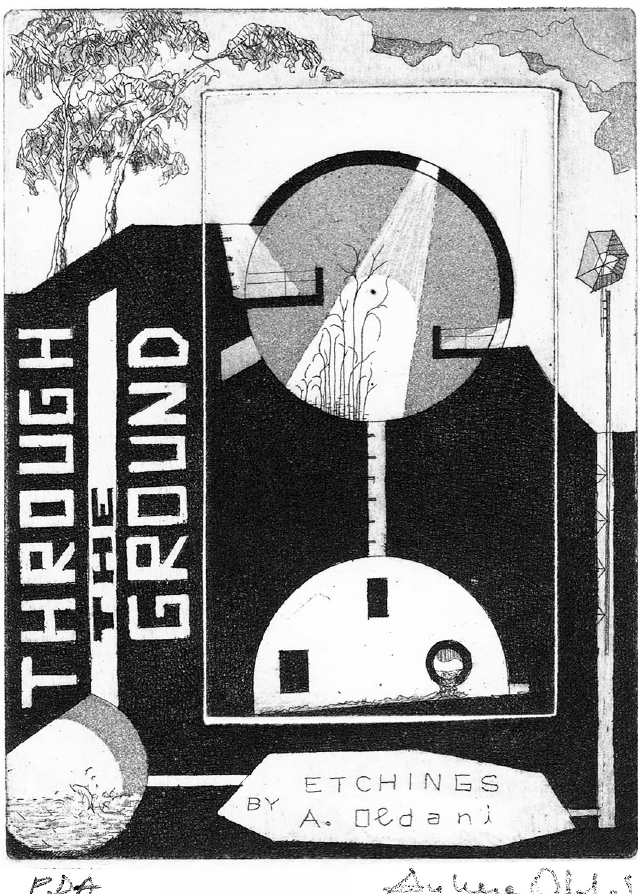
Fig. 1 Andrea Oldani, Through the ground , 2019. Composite frontespice, two plates, cm. 8,85 x 11,9.